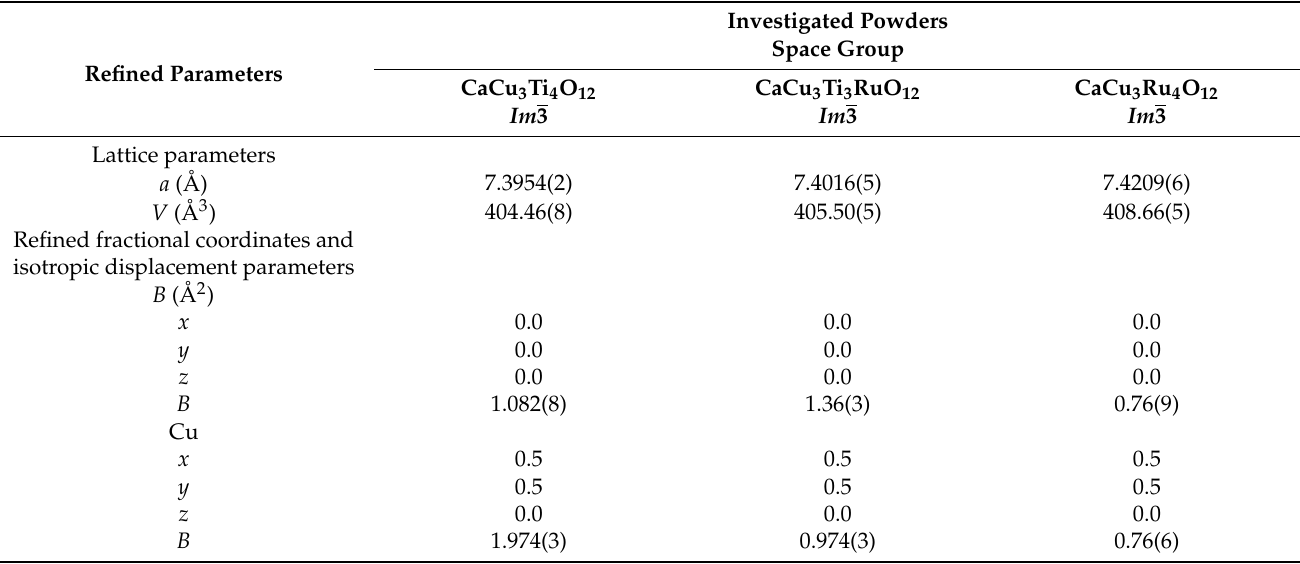
Table 1. The refined values of the fractional coordinates and isotropic displacement parameters of the CaCu 3 Ti 4 − x Ru x O 12